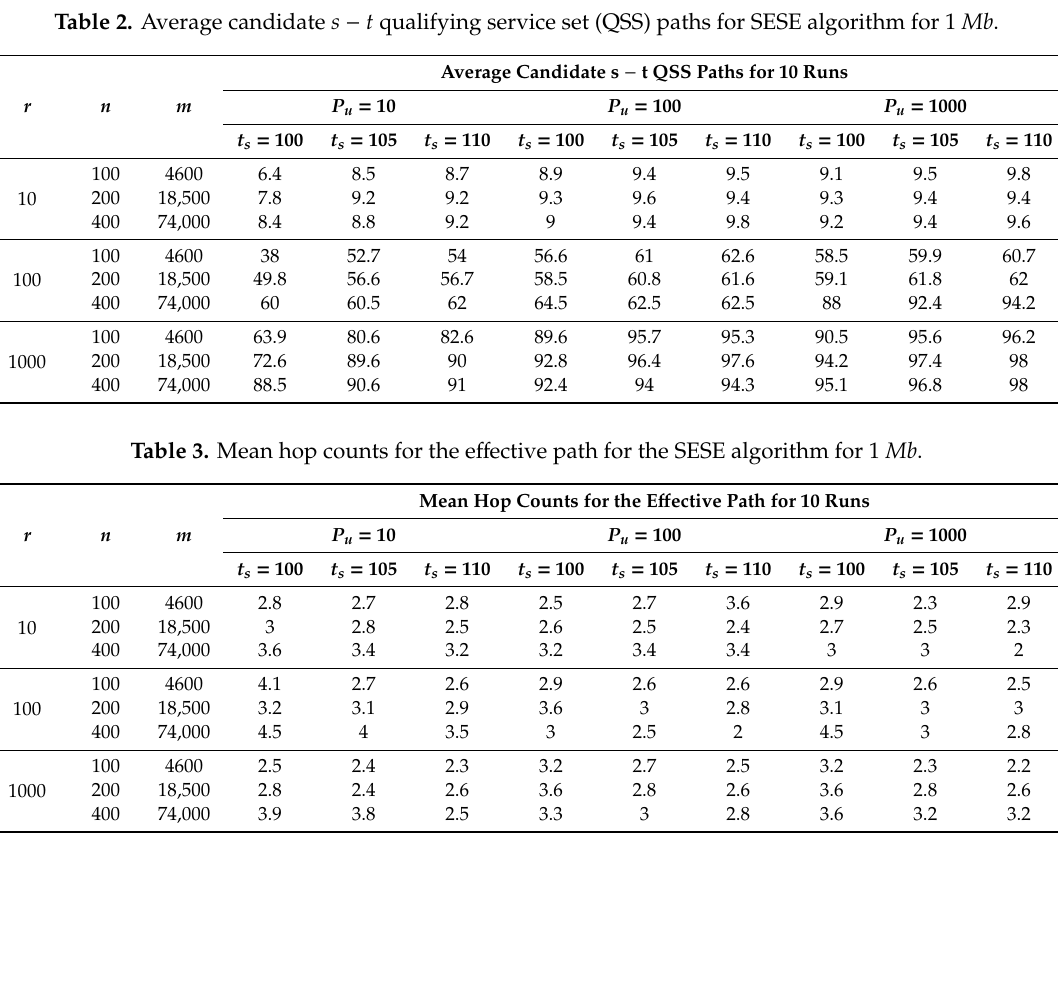
Table 2. Average candidate s − t qualifying service set (QSS) paths for SESE algorithm for 1 Mb .